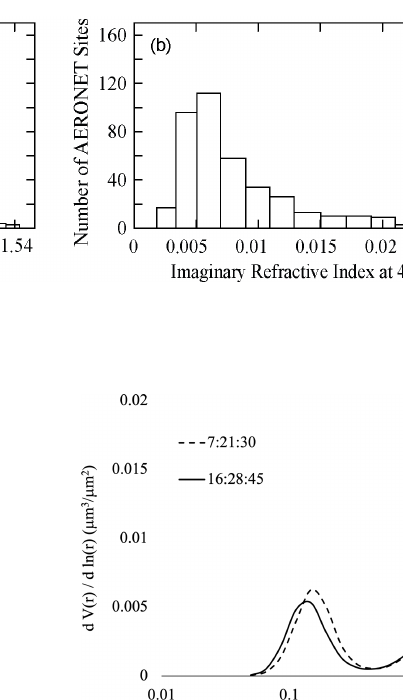
Figure 8. Percentage of sphericity frequency.